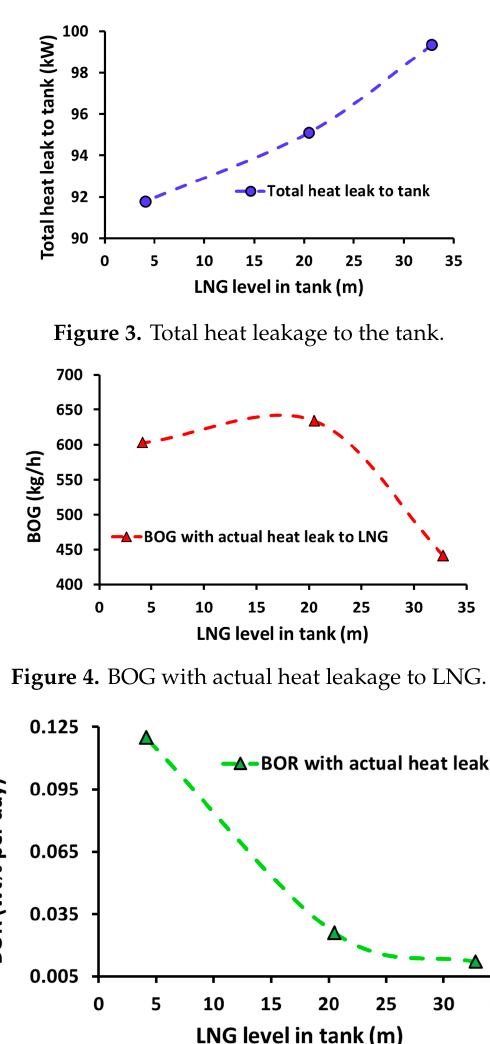
Figure 5. BOR with actual heat leakage to LNG.